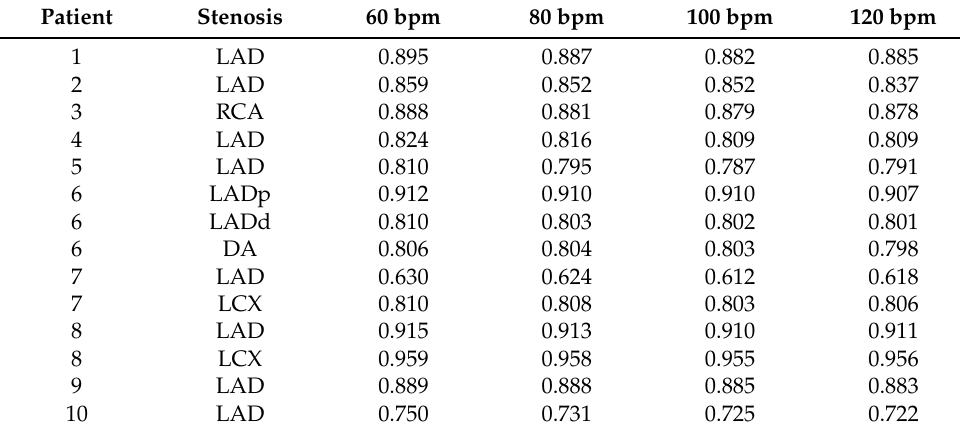
Table A2. FFR values for various heart rates.